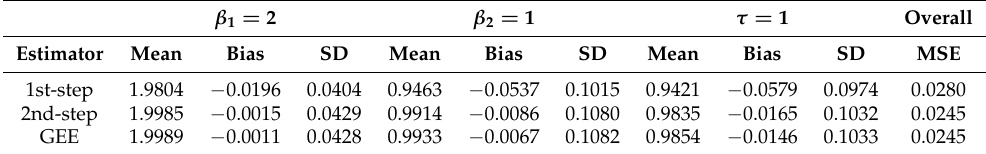
Table 2. Simulation estimation